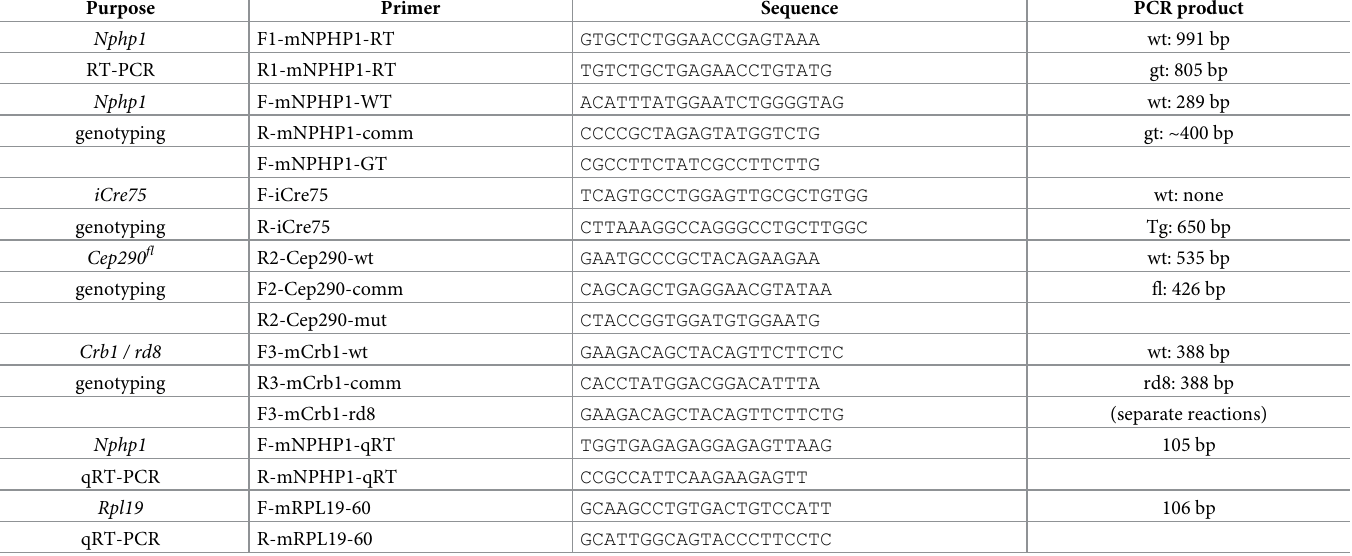
Table 1. Primers used in this